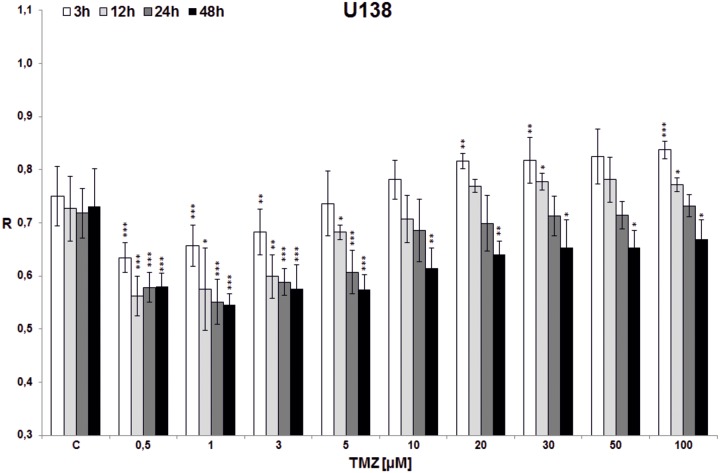
The effect of TMZ on total DNA methylation of U138 cell line.The analysis was performed after 3 (white bars), 12 (light grey bars), 24 (dark grey bars) and 48 (black bars) hrs of incubation in a given TMZ concentration (0.5–100 μM). Control cells (C) were treated with DMSO only. The R values are means from three experiments ±SD. Asterisks indicate a significant difference (*p < 0,05, **p < 0,01, ***p < 0,001) from the control (DMSO) value. A very little DNA hypermethylating effect is observed (for incubation times 3 and 12 hrs, over concentrations 20 and 30 μM respectively). Very clear initial hypomethylation is seen in TMZ concentrations up to 100 μM for incubation times of 24 and 48 hrs.